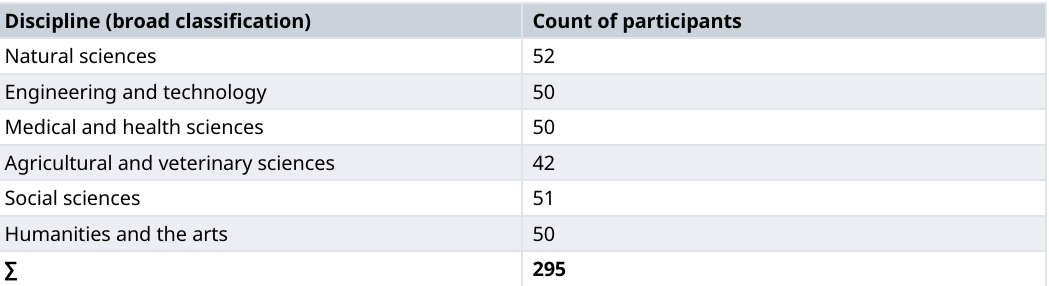
Table 1. Count of participants from each